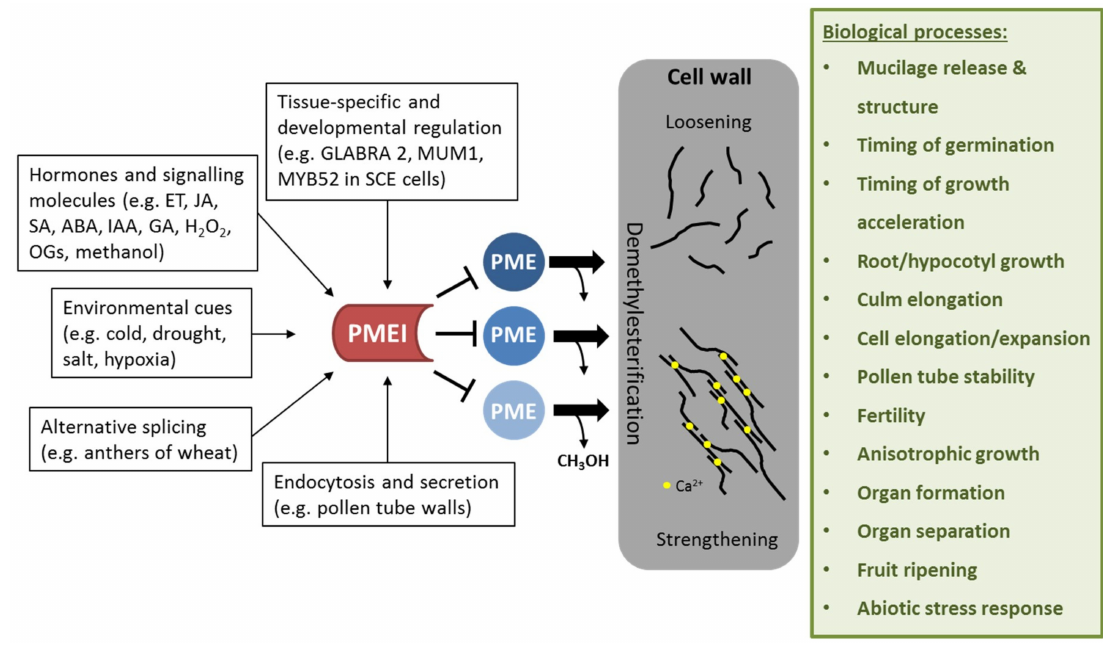
Figure 2. Effect of PMEI regulation on cell wall properties and biological processes affected by PMEI manipulation. PMEI s are transcriptionally regulated in a tissue-specific and development-dependent manner. Several plant hormones and signaling molecules as well as environmental stresses can activate PMEI gene expression. Alternative splicing and directed endocytosis and secretion regulate the level of active PMEIs in the cell wall. PMEI can inhibit several PME enzymes, thereby regulating de-methylesterification of HG. This in turn modulates cell wall properties such as loosening or strengthening, which is required for several biological